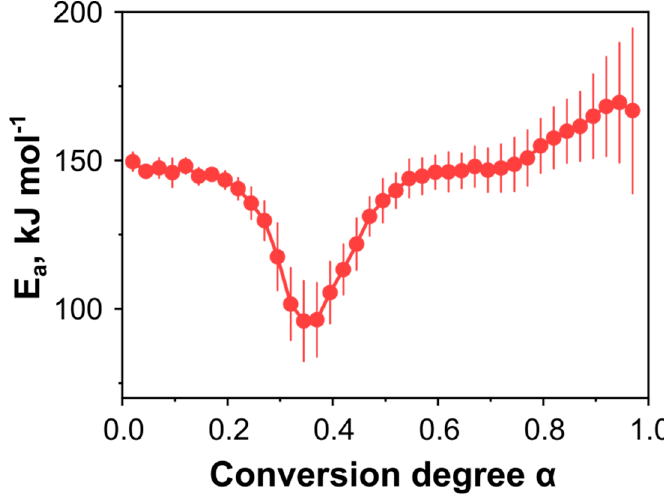
Figure 5. The apparent activation energy of the thermolysis of DBT was obtained by the isoconver- sional Friedman analysis from the DSC data under an elevated pressure of 2.0 MPa. Table 1. The kinetic parameters calculated using the different approaches for the non-isothermal PDSC data of DBT